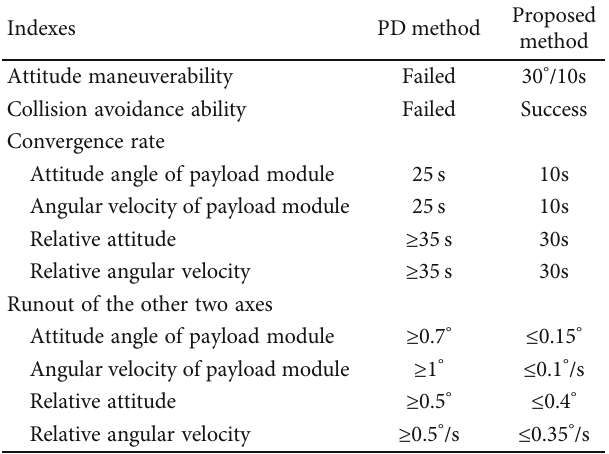
Table 2: Controller performance